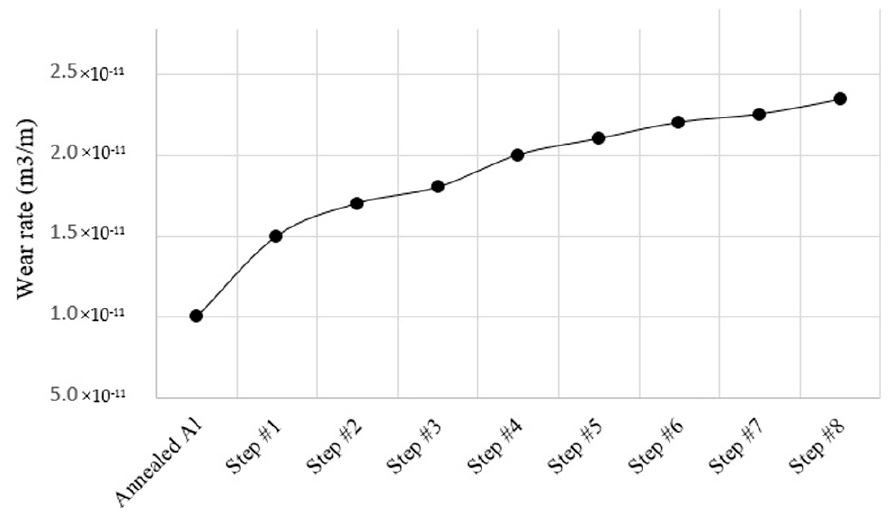
Figure 7. Weight loss in sliding wear for Al–TiC composite at different steps. × 10 − 11 .